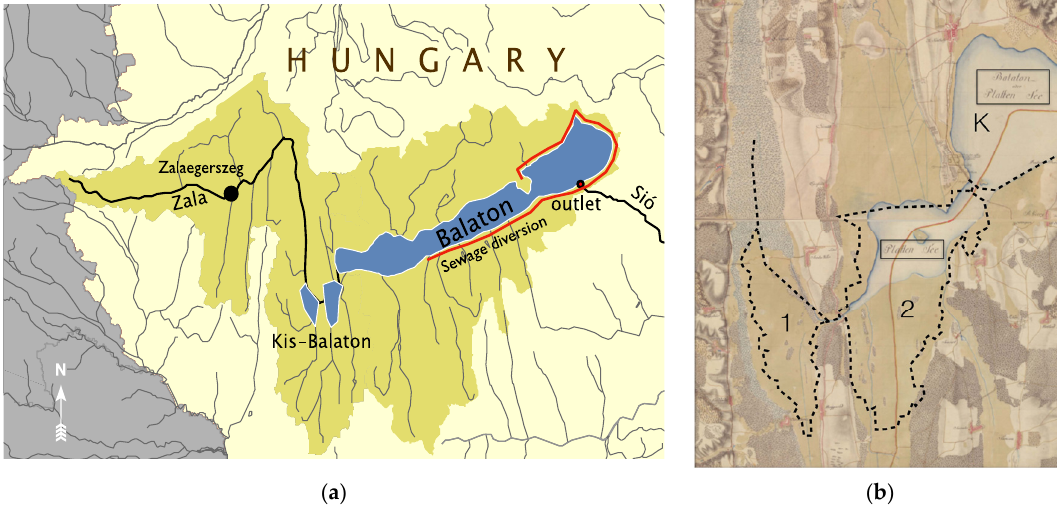
Figure 1. ( a ) Position of the Kis-Balaton wetlands within the Lake Balaton catchment. Zala is the largest tributary; Zalaegerszeg is the largest town upstream of Kis-Balaton. The red line indicates the sewage collector belt around Lake Balaton; ( b ) the western parts of Lake Balaton in the First Military Survey of Hungary (1782–1785, map slides with permission of Österreichischen Staatsarchiv) and the present outlines of the Kis-Balaton system. K: Keszthely Basin, presently the westernmost basin of Lake Balaton; 1 and 2: phases of the present Kis-Balaton system. “Lake Balaton” (in German, “ Platten See ” is written in the thin frames).